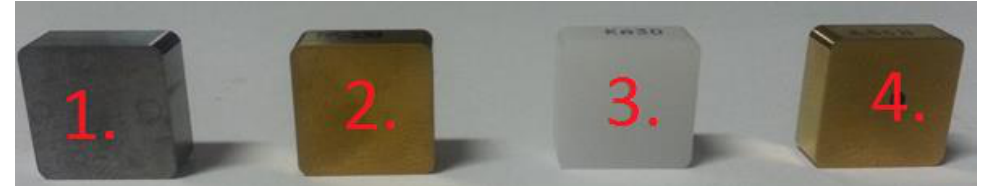
Figure 4. Cutting inserts (1) P20—Sintered carbide; (2) P20 + TiN—Sintered carbide with a standard coat—Korloy company; (3) Al2O3—Cutting ceramics; (4) Al2O3 + TiN—Cutting ceramics with a standard coat—Korloy company.